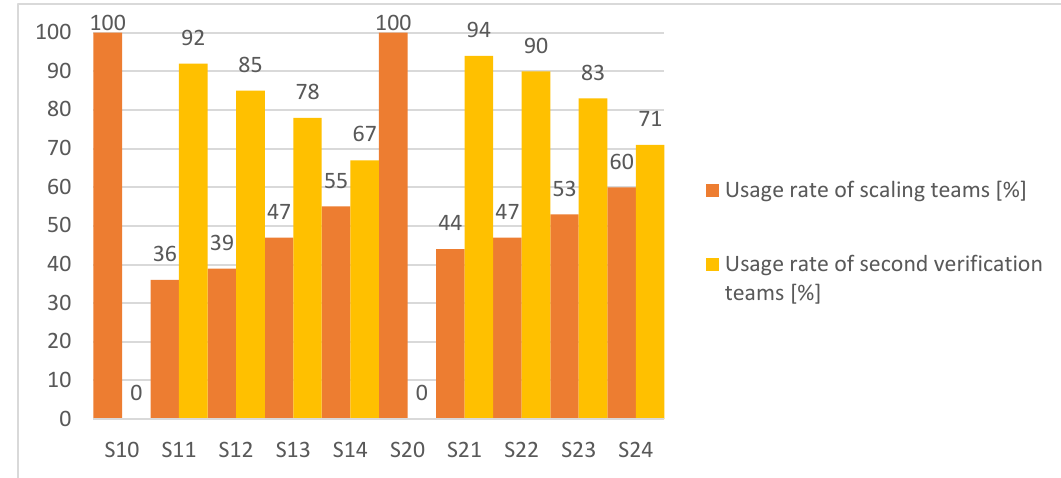
Figure 10. The usage rates of the serving teams.